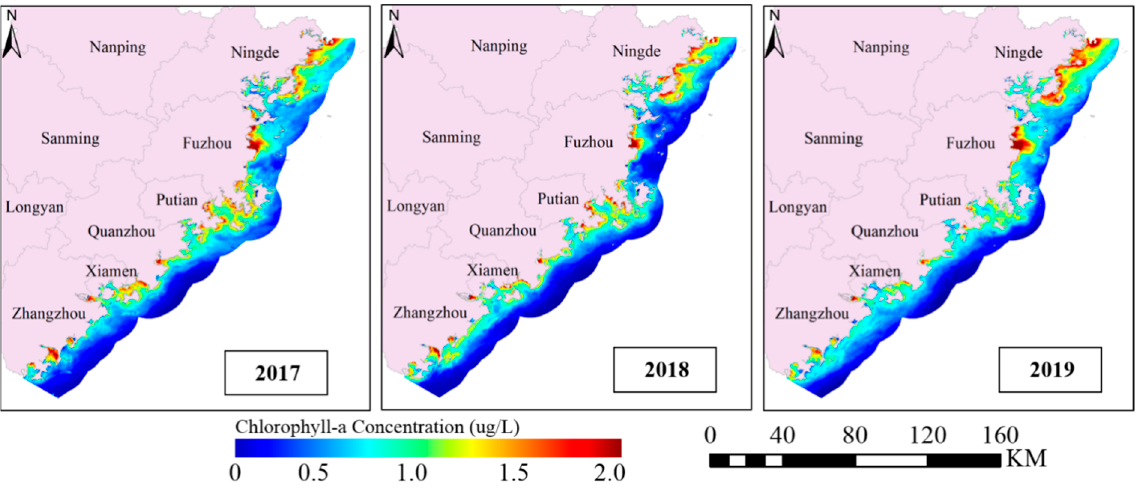
Figure 5. Spatial distribution of the annual average chl-a concentration based on the LightGBM-Case 4 model using the OLCI images from 2017 to 2019 in Fujian’s coastal waters.